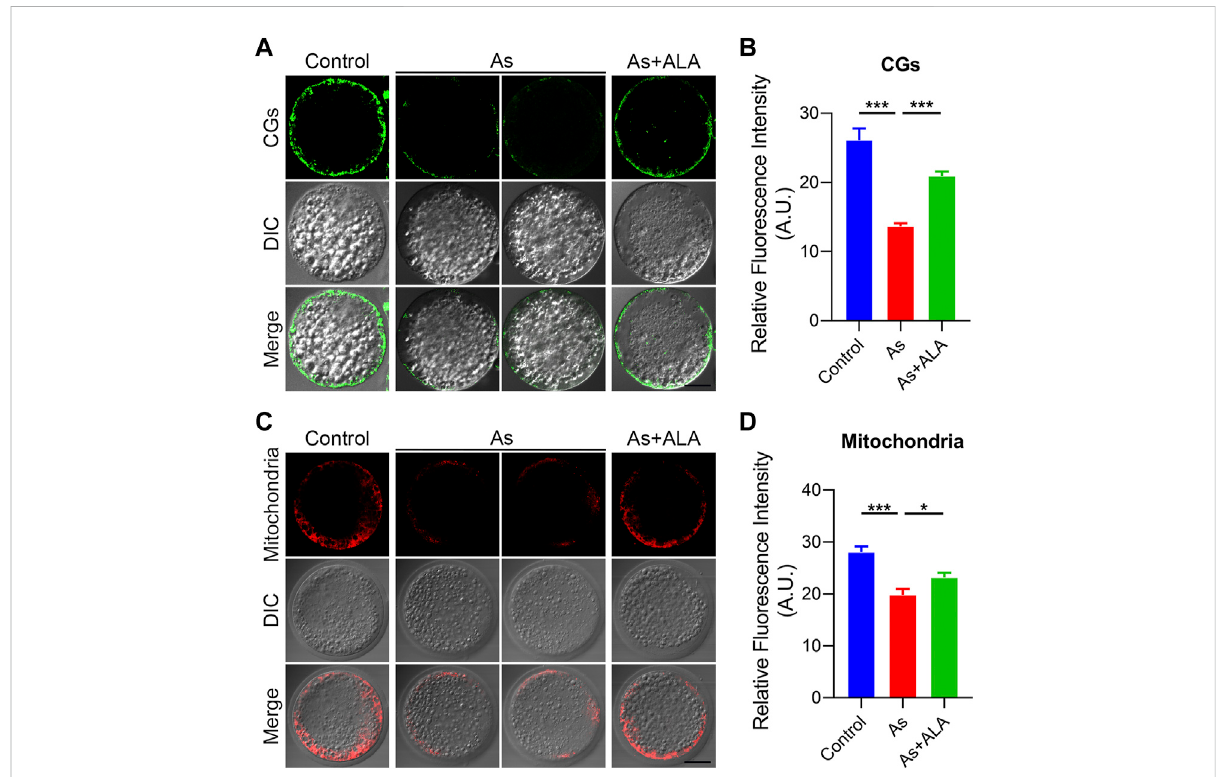
Effect of ALA supplementation on the localization of cortical granules and mitochondrial integrity in arsenite-exposed oocytes. (A) Representative images of the localization of cortical granules in control, arsenite-exposed and ALA-supplemented groups. LCA-FITC was used to show the CGs in the oocytes. Scale bar, 30 µm. (B) The fl uorescence intensity of cortical granules in control, arsenite-exposed and ALA- supplemented groups. (C) Representative images of the mitochondrial integrity in control, arsenite-exposed and ALA-supplemented groups. Scale bar, 30 µm. (D) The fl uorescence intensity of mitochondrial signals in control, arsenite-exposed and ALA-supplemented groups. Data were presented as mean percentage (mean ± SEM) of three independent experiments. * p < 0.05, *** p <